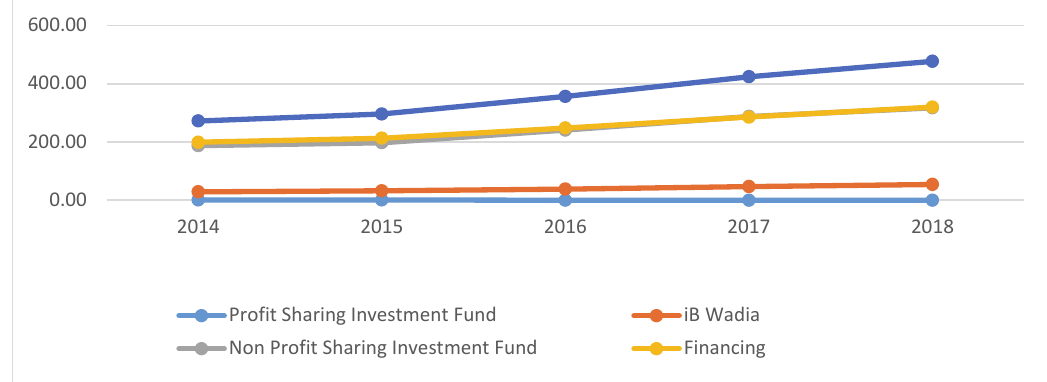
Fig. 1. The Growth of Sharia Banking in